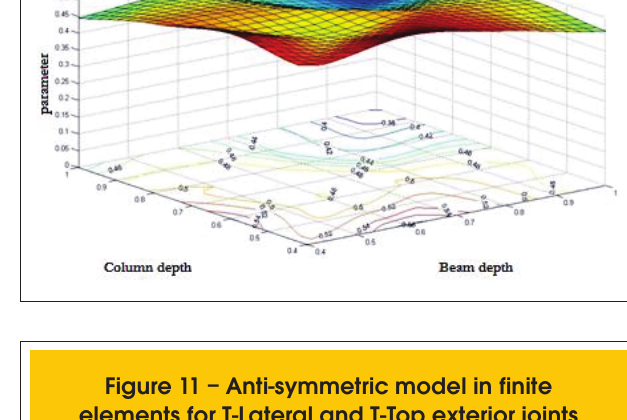
Figure 12 – Finite element anti-symmetric model for L-type joints